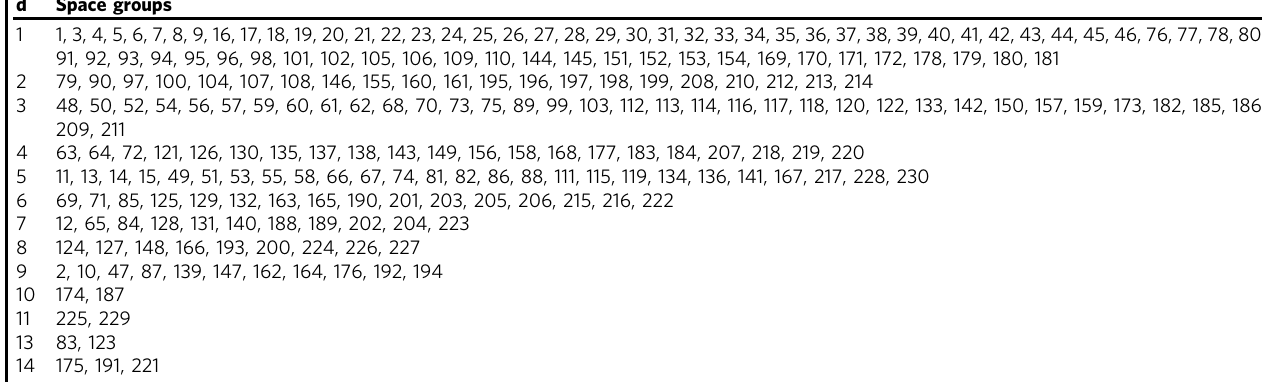
Table 1 Characterization of band structures for systems with time-reversal symmetry and signi fi cant spin – orbit